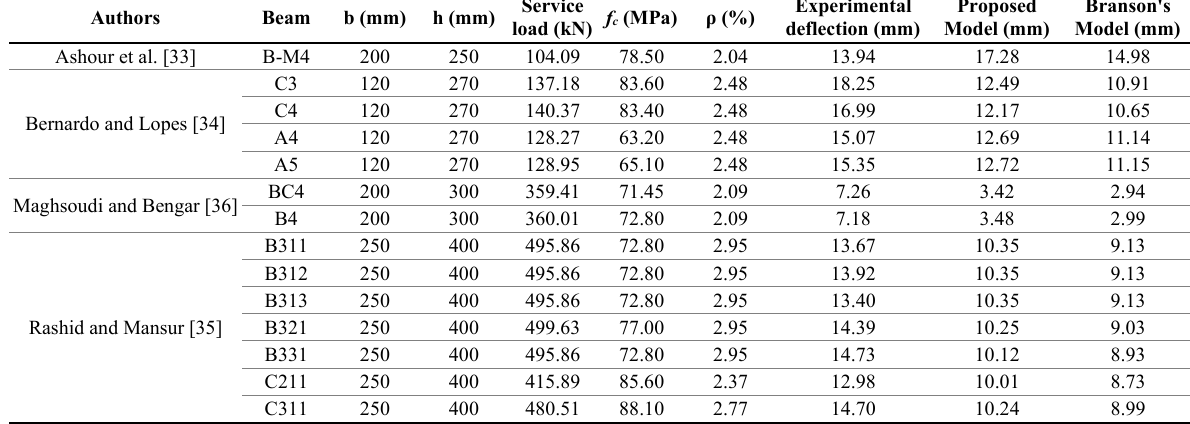
Table A5. Beams data with f c from 50MPa to 90MPa and reinforcement rate from 2% to 3%.